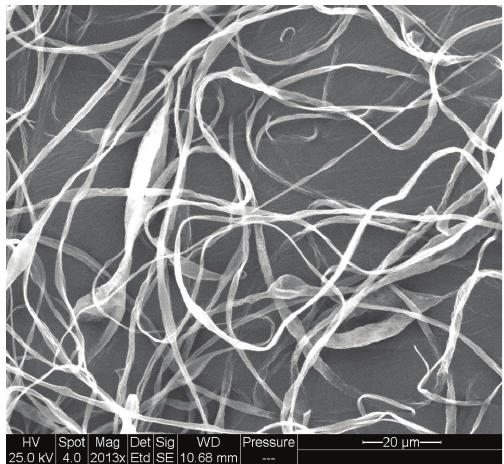
Figure 2: SEM image of 1% PFMOP nanofibers.